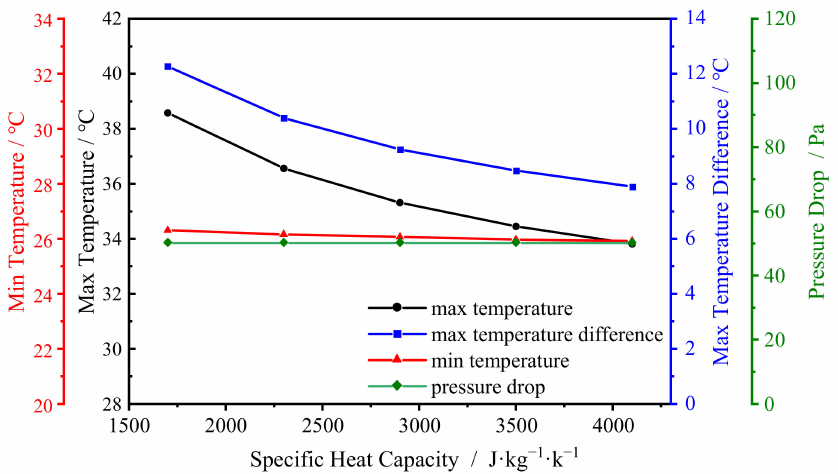
Figure 12. Relationship between the specific heat capacity of the coolant and the MAT, MIT, MATD of the cell, as well as the pressure drop of the